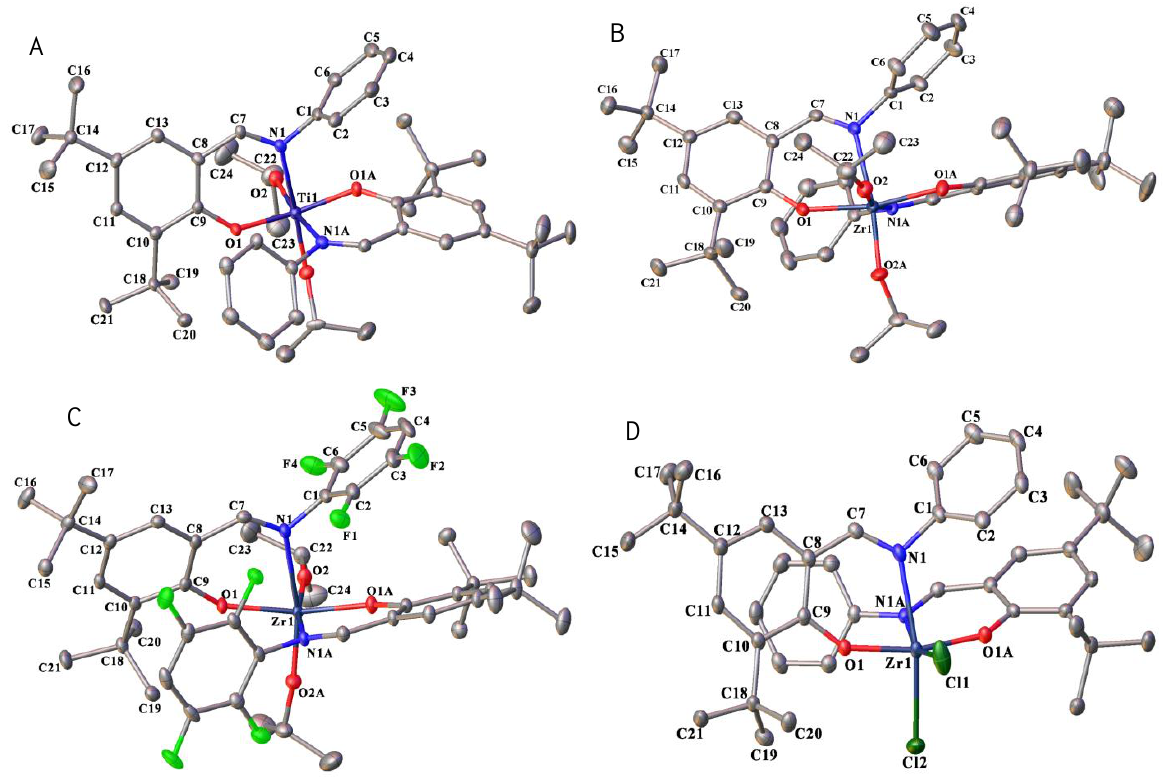
Figure 2. ORTEP representation of the molecular structure of complexes ( L1) 2 Ti(OiPr) 2 ( A ), ( L1) 2 Zr(OiPr) 2 ( B ), ( L2) 2 Zr(OiPr) 2 ( C ), ( L1) 2 ZrCl 2 ( D ) and with thermal ellipsoids drawn at the 30% probability level.